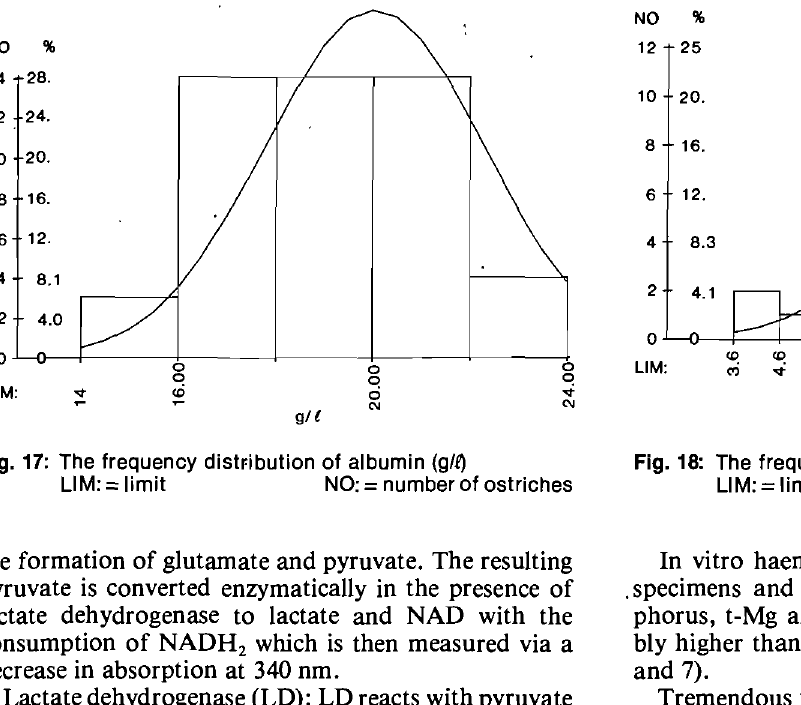
Fig. 17: The frequency distr-ibution of albumin (gft) LI M: == limit NO: == number of ostriches the formation of glutamate and pyruvate. The resulting